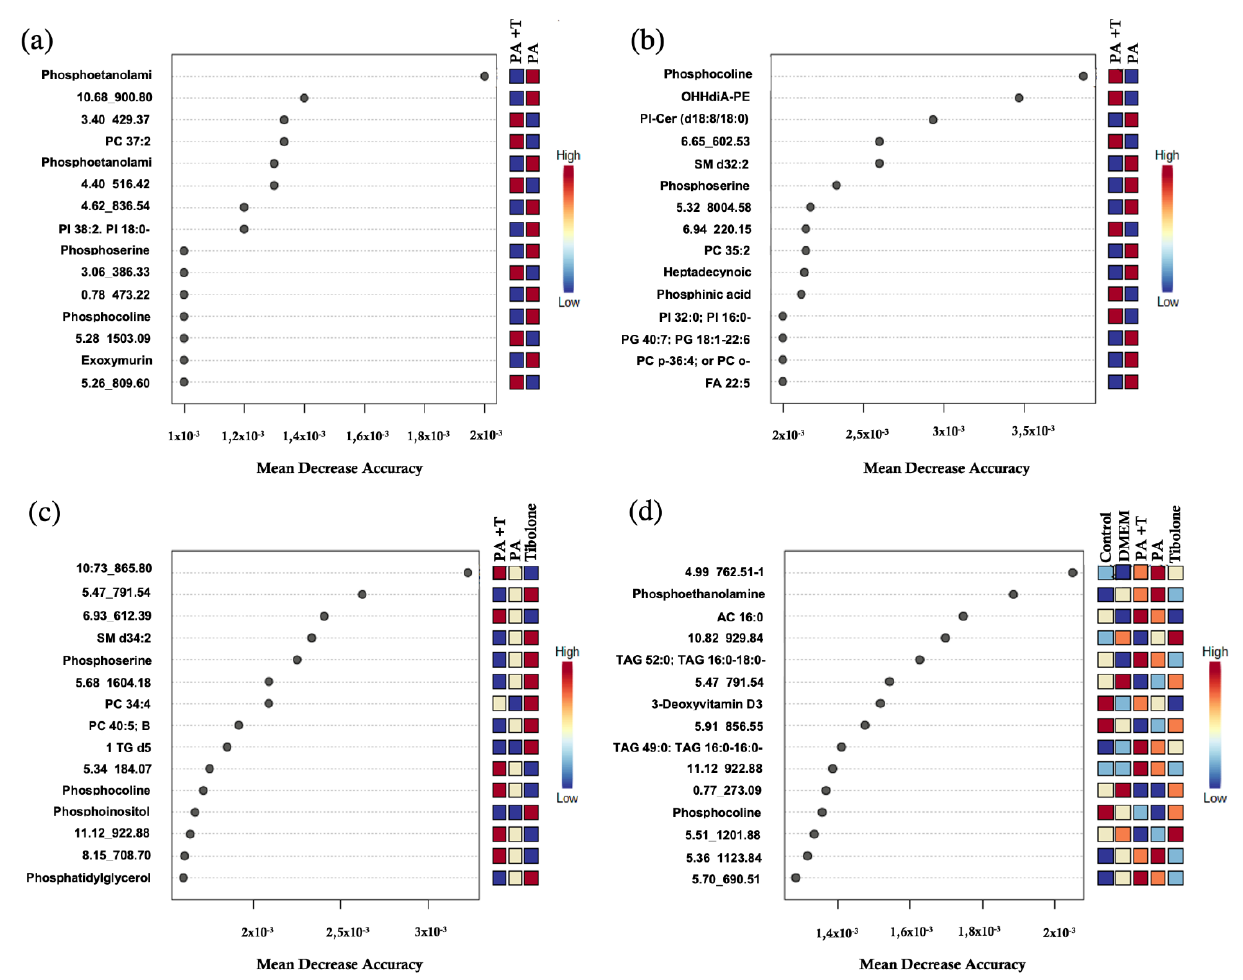
Figure 4. Random Forest for endometabolone analysis. ( a ) PA + T & PA ( b ) PA + T & T ( c ) PA + T & PA & T and ( d ) complete treatments. The list of the first 15 metabolites highlighted by their mean decrease accuracy value is presented for each evaluated treatment set. These metabolites have been reviewed in the literature and related to metabolic processes in humans within the present study.